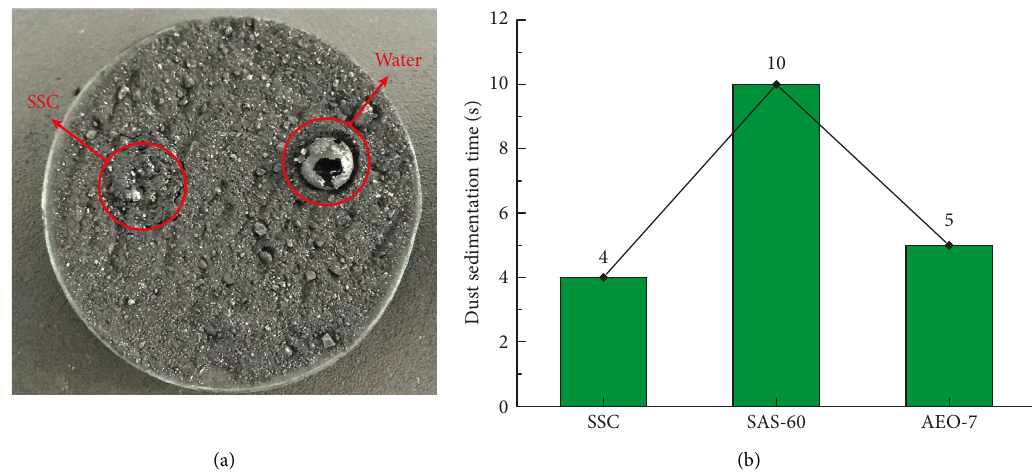
Figure 6: Wetting performance results of the SSC. (a) Comparison diagram of the wetting performances of the SSC and water. (b) Comparison of the dust sedimentation times of the SAS-60, AEO-7, and SSC.